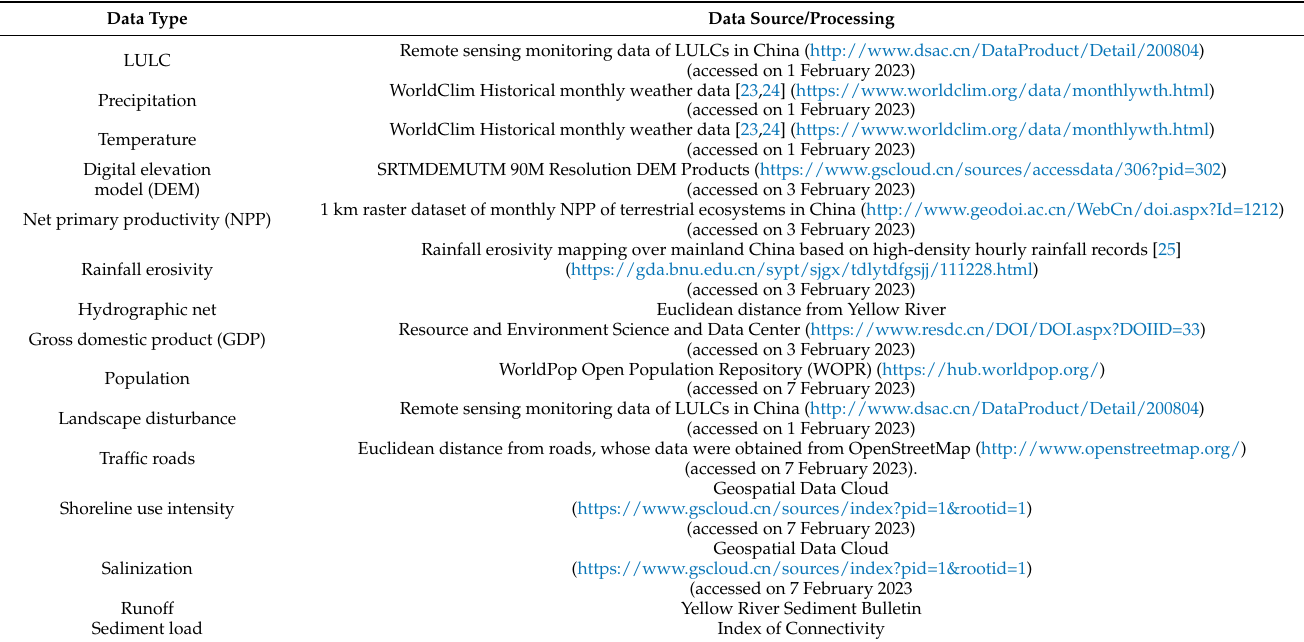
Table 1. Summary of the primary data.